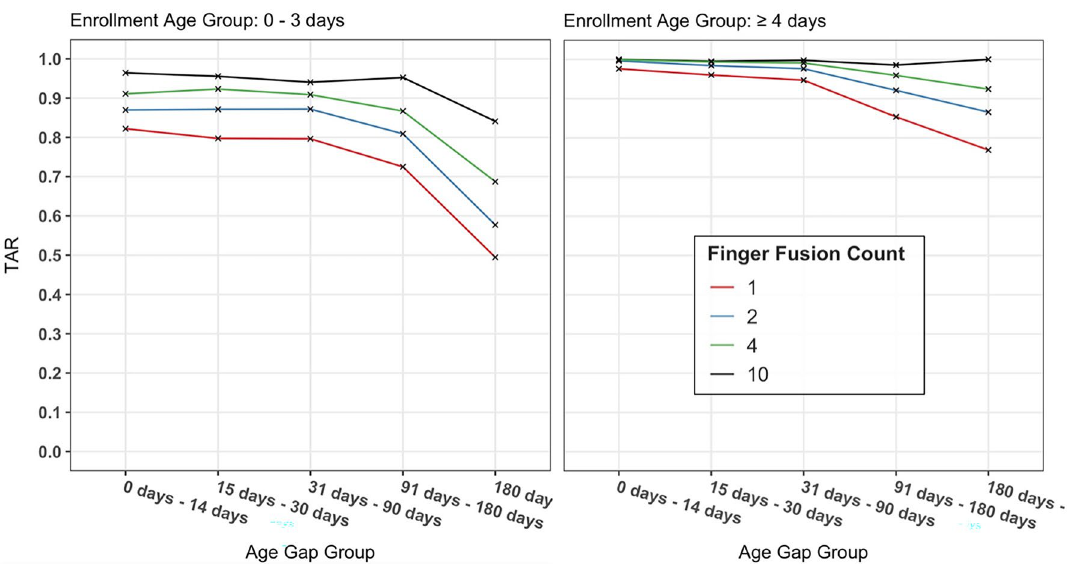
Figure 3. The effect of age at enrollment and time gaps between enrollment and verification up to 180 days, for (Left) enrollment age group 0–3 days and (Right) for the enrollment age group of 4 days and older.